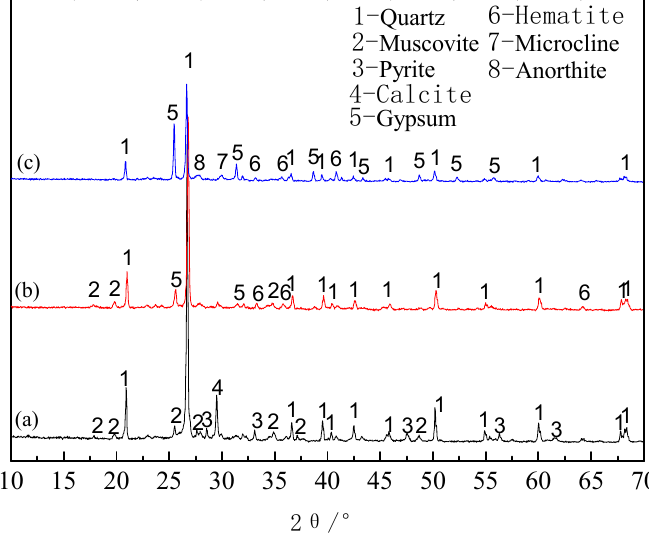
Figure 6. XRD image for ( a ) raw ore; ( b ) blank roasted clinker; and ( c ) calcified roasted clinker. Table 3. Chemical multi-elemental analysis of the raw ore, blank roasted clinker, and calcified roasted clinker, wt %.